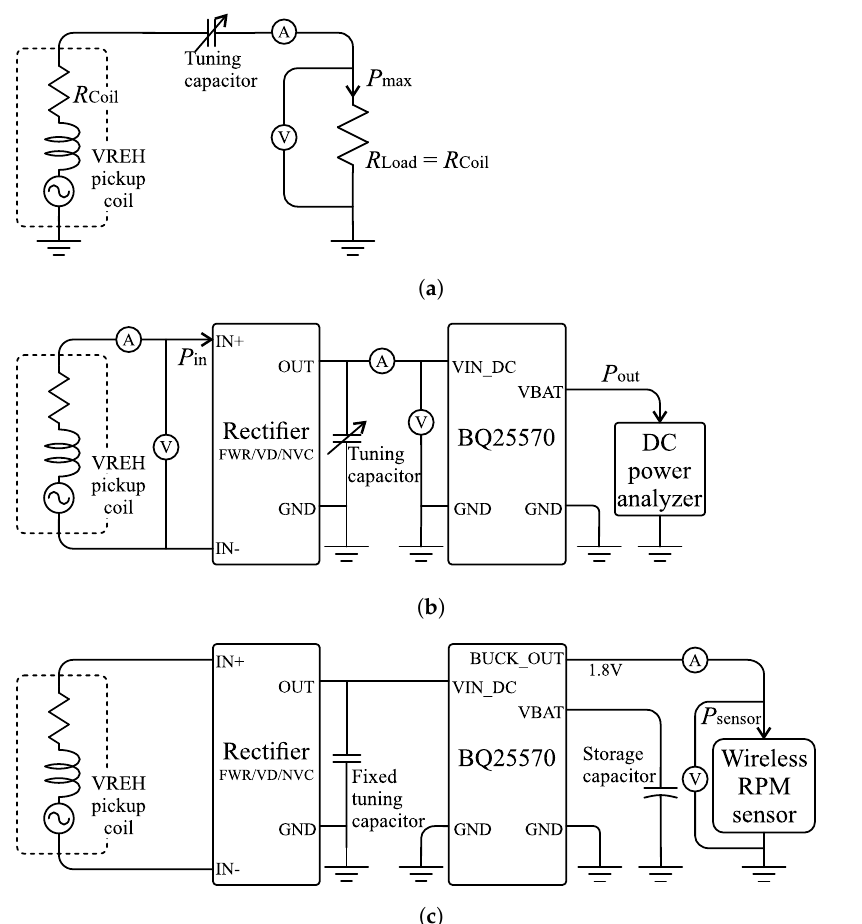
Figure 8. Schematic diagrams of the experimental setups for ( a ) evaluating maximum output power under impedance matched load; ( b ) evaluation of the interface circuit implementations; and ( c ) the full system evaluation with a wireless RPM sensor as the electrical